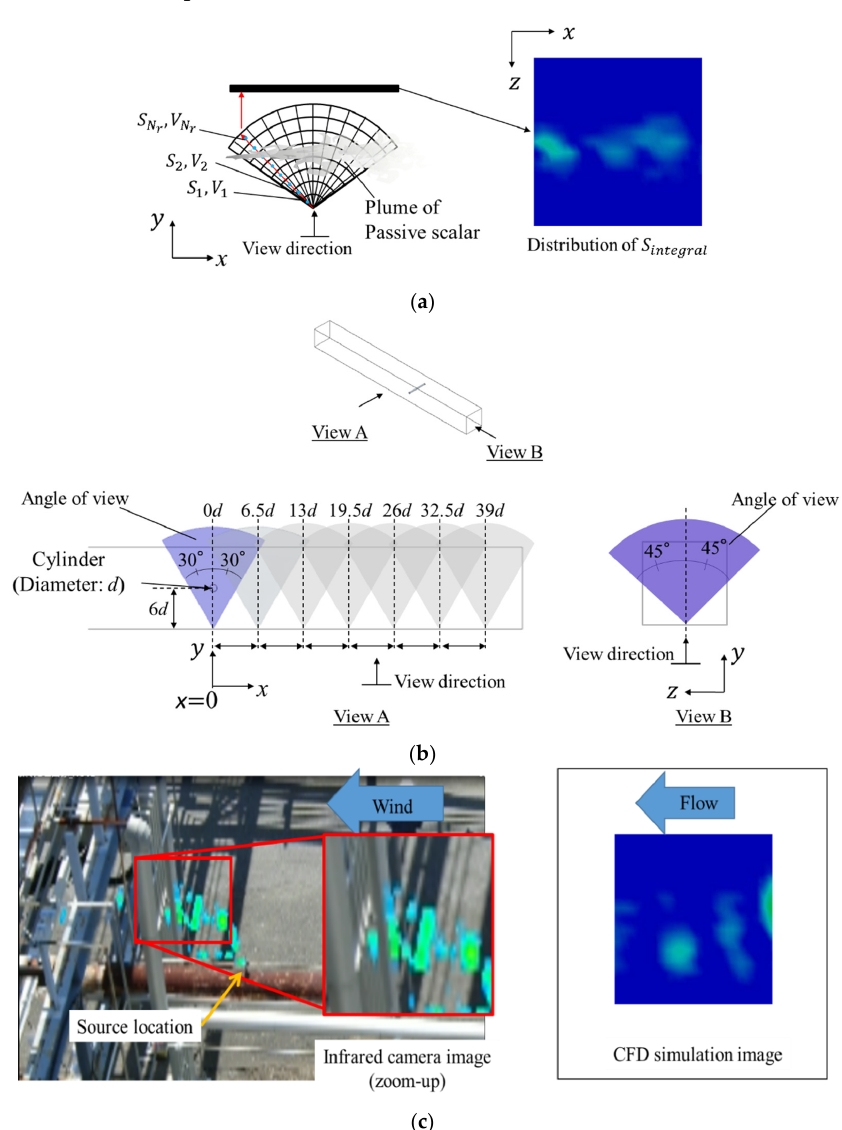
Figure 3. Scalar concentration images for machine learning: ( a ) conceptual diagram of distribution for S integral : blue color indicates S integral = 0 and red color indicates the highest passive scalar, which occurs at the source inlet; ( b ) angle of view for the image in x-y and y-z planes; ( c ) comparison of an infrared camera sample image [20] and a CFD simulation image.